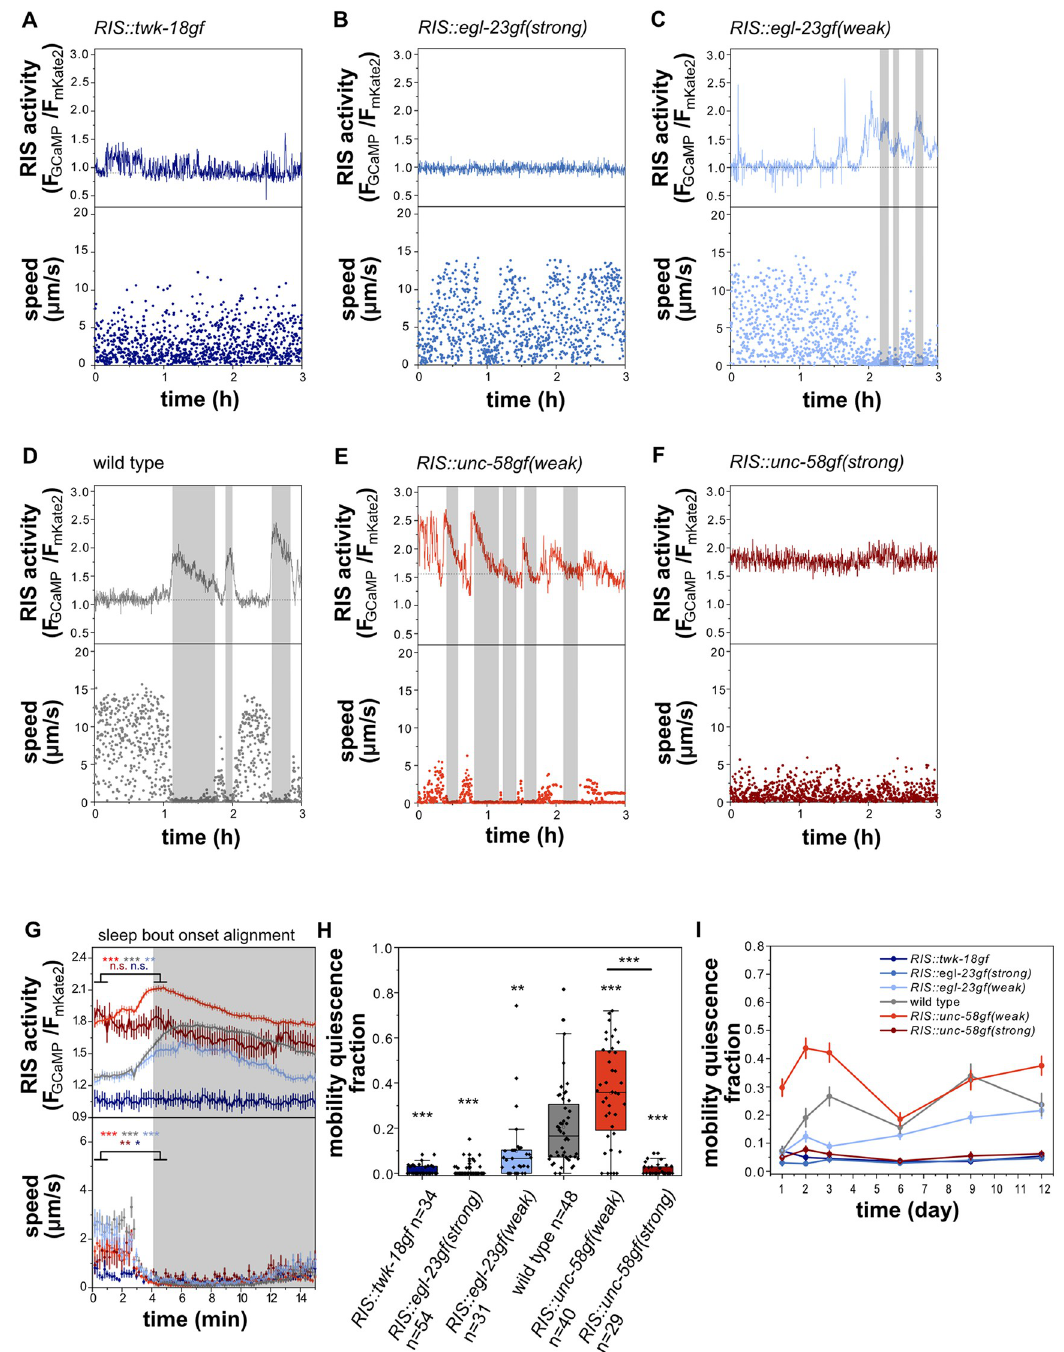
Fig 4. Both, strong inactivation of RIS as well as RIS :: unc-58gf(strong) prevent sleep behavior during L1 arrest. A-F) Ion channel expression in RIS controls calcium activity and sleep behavior. Mobility quiescence bouts (grey shade) correlate with RIS transients. Movement speed was calculated by tracking the position of the head neuron RIS. A) RIS :: twk-18gf and B) RIS :: egl-23gf (strong) larvae do not have detectable mobility quiescence bouts or RIS transients. C) RIS :: egl-23gf(weak) has reduced mobility quiescence bouts. D) Wild-type RIS activation transients and immobility bouts. E) RIS :: unc-58gf(weak) spends more time in mobility quiescence bouts. F) RIS :: unc-58gf(strong) has no detectable mobility quiescence bouts and no RIS transients but a high constant activity. G) RIS activation and immobility are correlated only for the strains that also show sleeping behavior. Alignment of RIS activity and speed to mobility quiescence bout onset. �� p < 0.01, ��� p < 0.001, Wilcoxon signed rank test. H) Mobility quiescence is a function of RIS activity levels n.s. p > 0.05, �� p < 0.001, ��� p < 0.001, Welch test with FDR correction for multiple testing. I) Long- term sleep fraction for RIS activity strains from day 1 to day 12 of